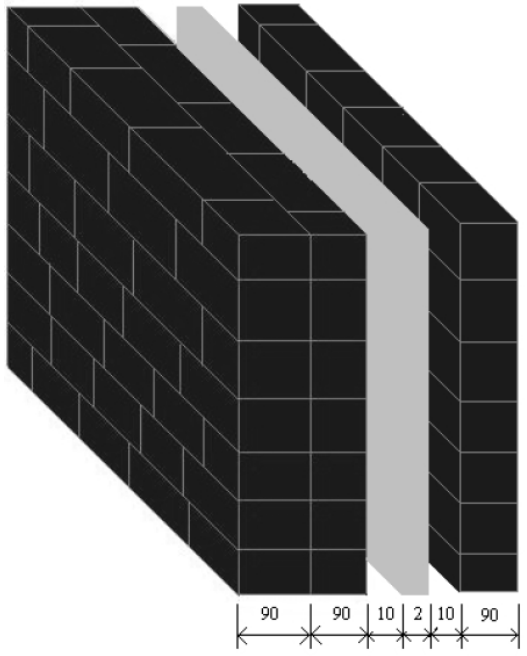
Figure 2. Wall construction